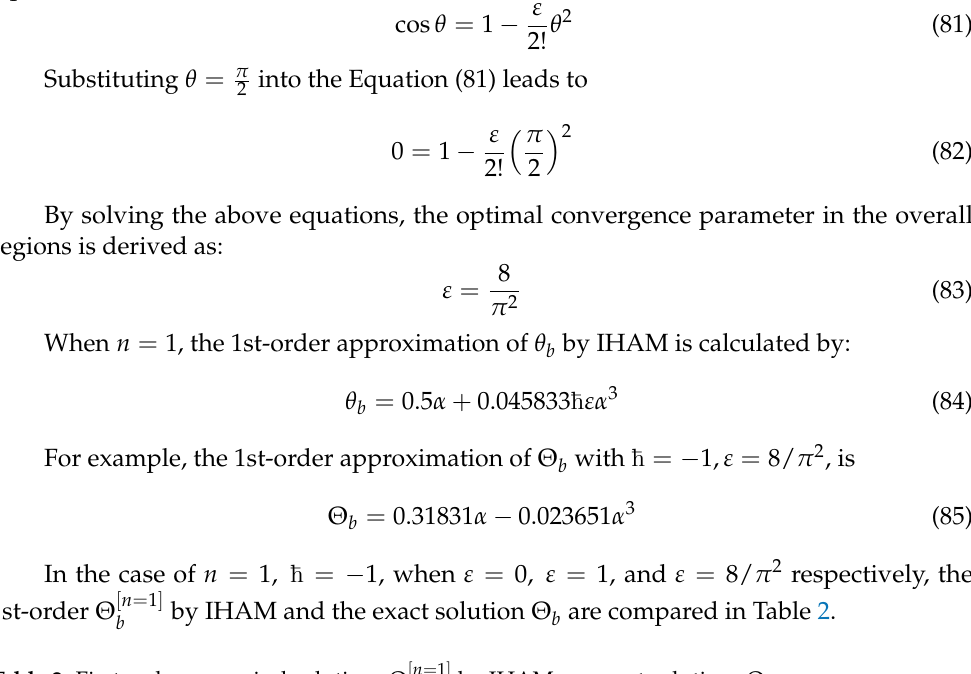
Table 2. First-order numerical solutions Θ